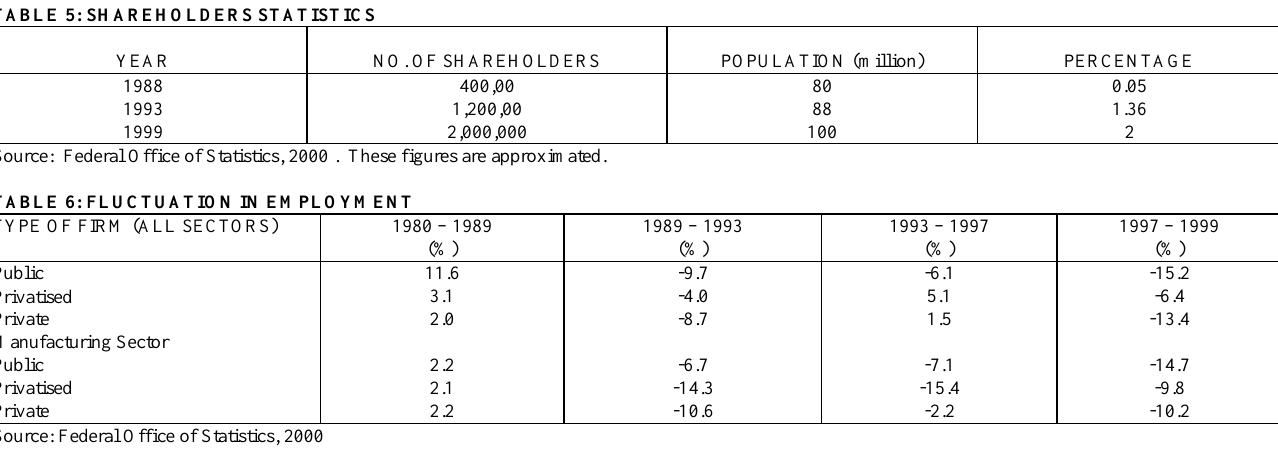
TABLE 7: PERFORMANCE OF SOME COMMERCIALIZED PUBLIC ENTERPRISES AS PER GROSS EARNINGS IN N BILLION 1992